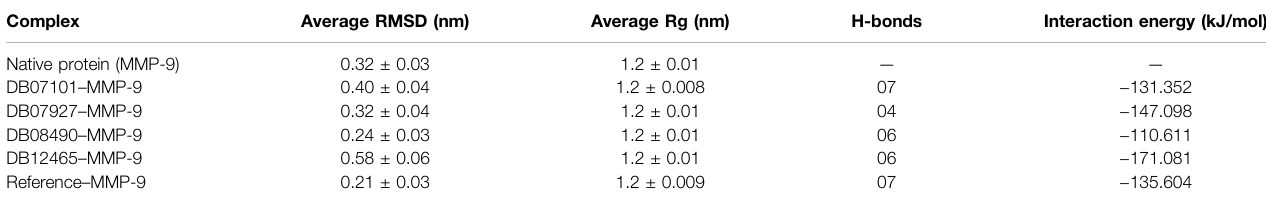
TABLE 3 | Average values of different parameters, RMSD, Rg, H-bonds, and interaction energy.